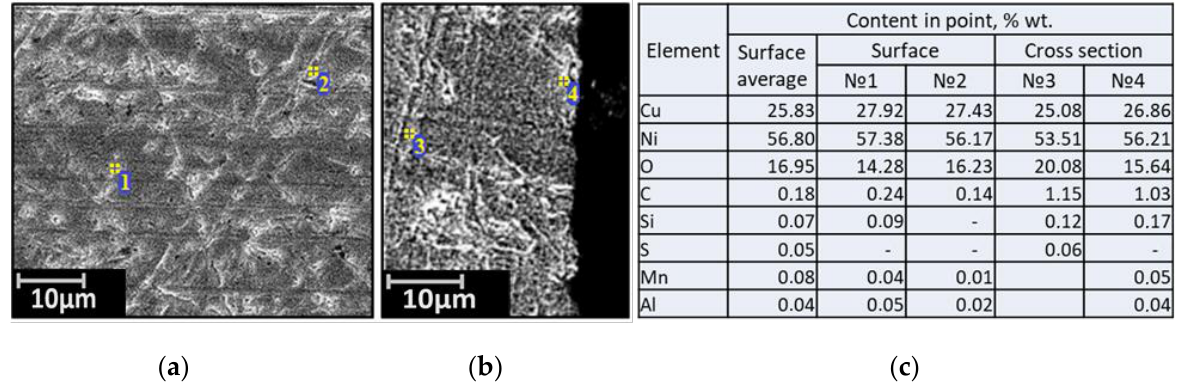
Figure 3. Micrographs of the surface ( a ), the cross-section ( b ), and the elemental composition ( c ) of the source material Monel 404.